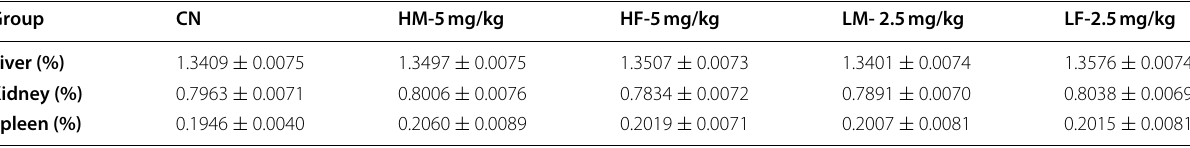
Table 2 Percentage liver, kidney and spleen coefficient in rats administered Mystomate4 ® at different doses for 3 months and control administered the vehicle